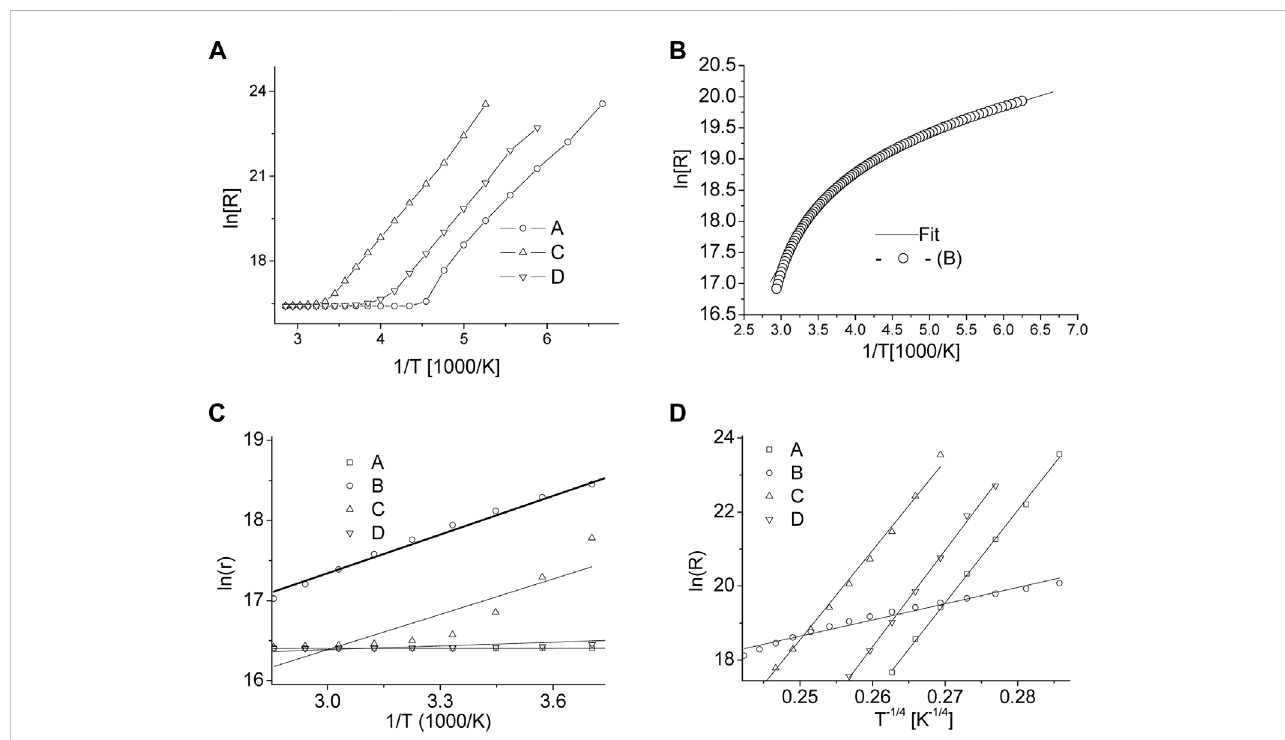
FIGURE 7 (A) Distinctive two-slope logarithmic-dependence of resistivity with sample cooling indicates an early thermally activated conduction which is followed by hopping mode of conduction at lower temperatures. (B) Experimental data and TA mode of conduction fi tting for sample-B shows a singular conduction process. (C) Fitting of the temperature experimental data (T ≥ 250 K) with phonon assisted TA mode of conduction also explained in the text. (D) Fitting of the low temperature experimental data (T ≤ 250 K) with variable range hopping conduction model as described in the